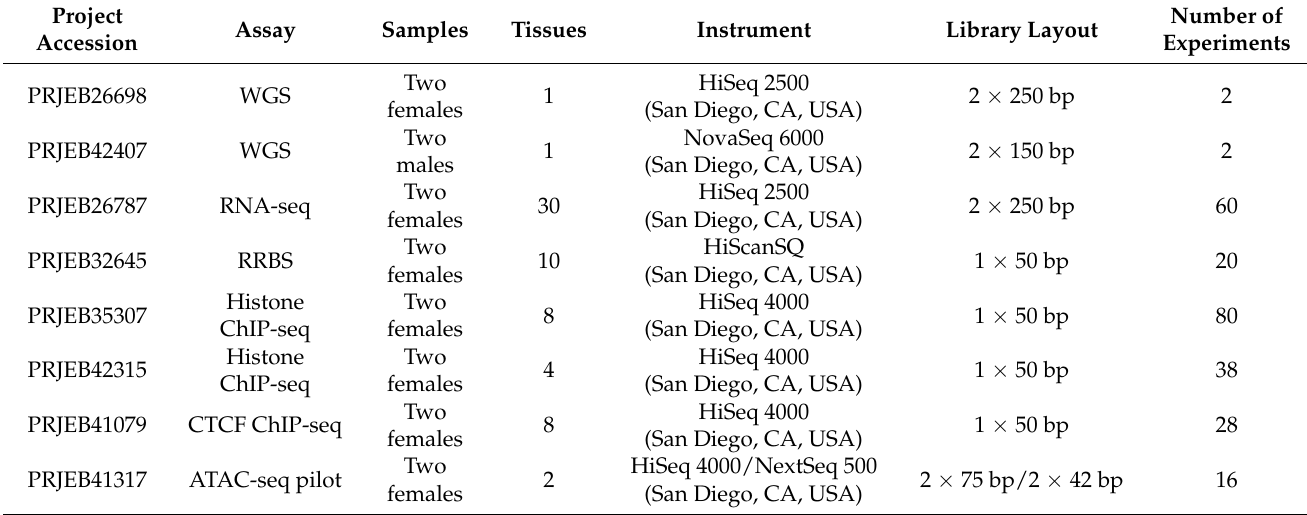
Table 1. Overview of Available Data and Assay